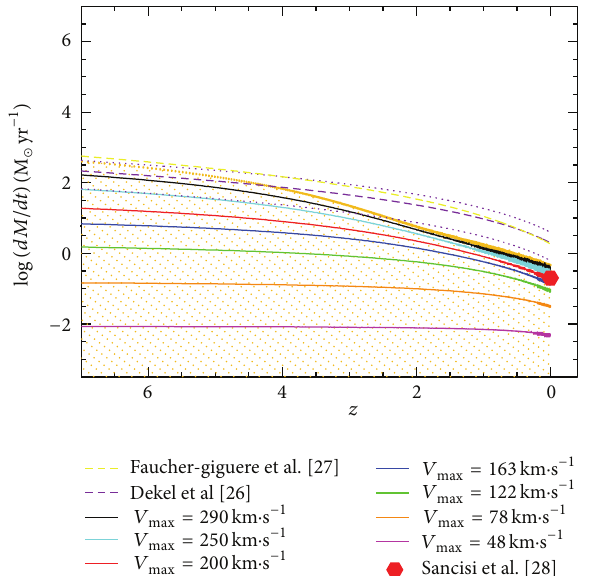
Figure 2: The evolution of the infall gas rate along the redshift 𝑧 for all radial regions of our 44 galaxy mass values represented by the shaded zone. The solid lines show the evolution of the whole infall rate of the same 7 theoretical galaxies shown in Figure 1 with the same color coding. The higher the total mass, the higher the infall rate. Dashed purple and yellow lines represent the prescriptions from Dekel et al. [77] and Faucher-Gigu`ere et al. [78], respectively. The dotted purple lines are the Dekel et al. [77] prescriptions for masses 2 × 10 12 M ⊙ and 3 × 10 11 M ⊙ , while the red hexagon in the present time is the estimated value given by Sancisi et al.